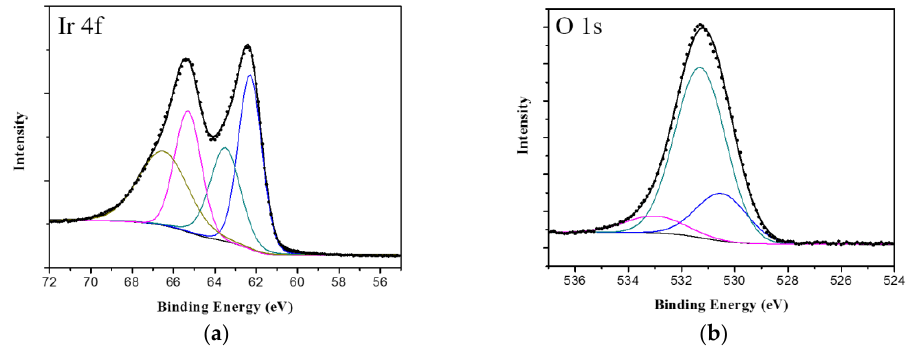
Figure 3. XPS spectra of the surface of iridium oxide film: ( a ) the detailed Ir4f region; and ( b ) the detailed O1s region.